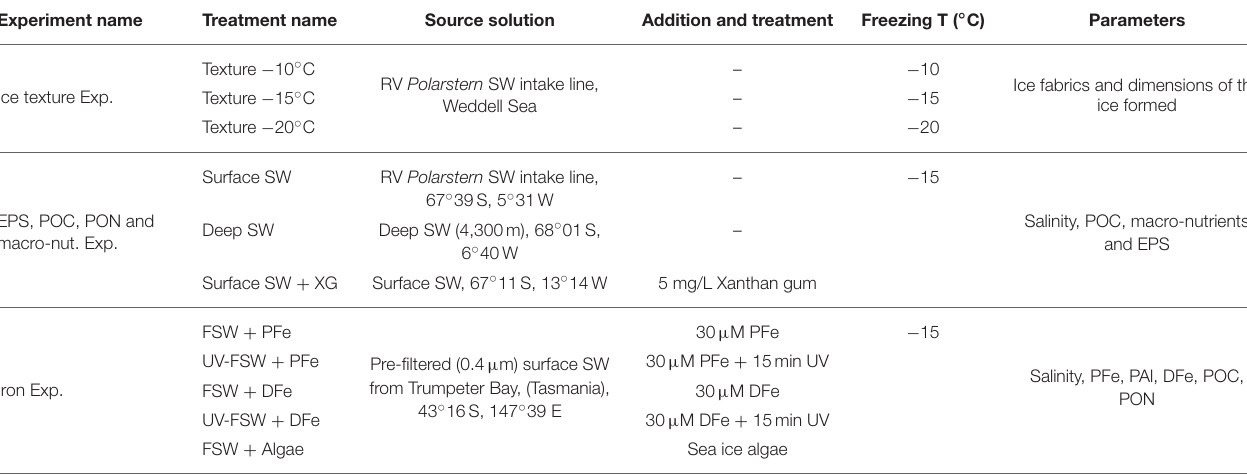
TABLE 1 | Summary of the different cold-finger